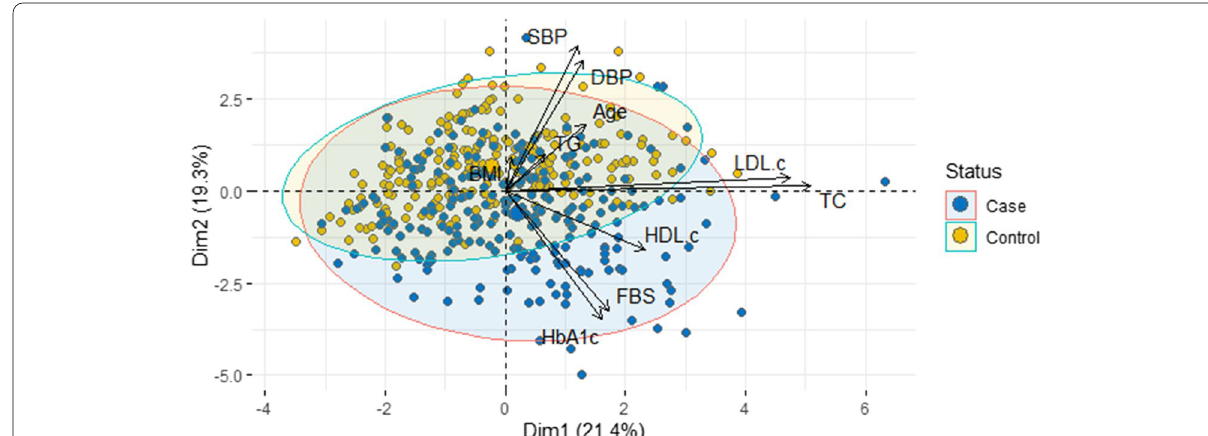
Fig. 5 Principal component analysis (PCA) biplot illustrating the relationships among study features and the clustering patterns in subjects with T2DM and no T2DM based on orthogonal linear combinations of the features. Glycated Haemoglobin (HbA1c), Total cholesterol (TC); Body Mass Index (BMI); Fasting Blood Sugar (FBS); Diastolic blood pressure (DBP); Triglycerides (TG); Systolic Blood Pressure (SBP); High Density Lipoprotein cholesterol (HDL‑c); Density Lipoprotein cholesterol